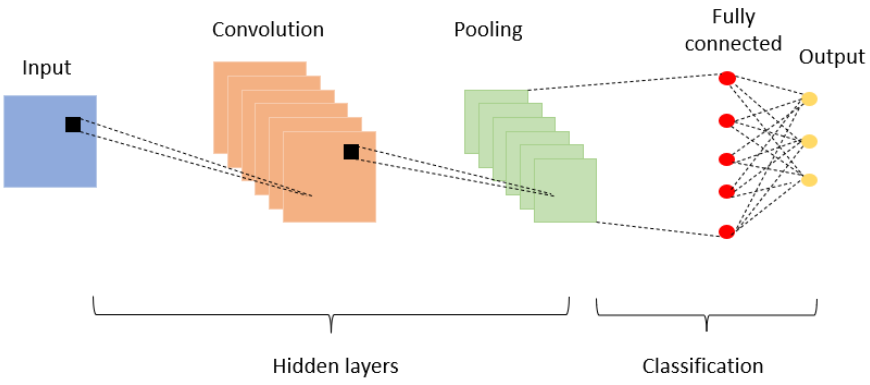
Figure 1. Architecture of a convolutional neural